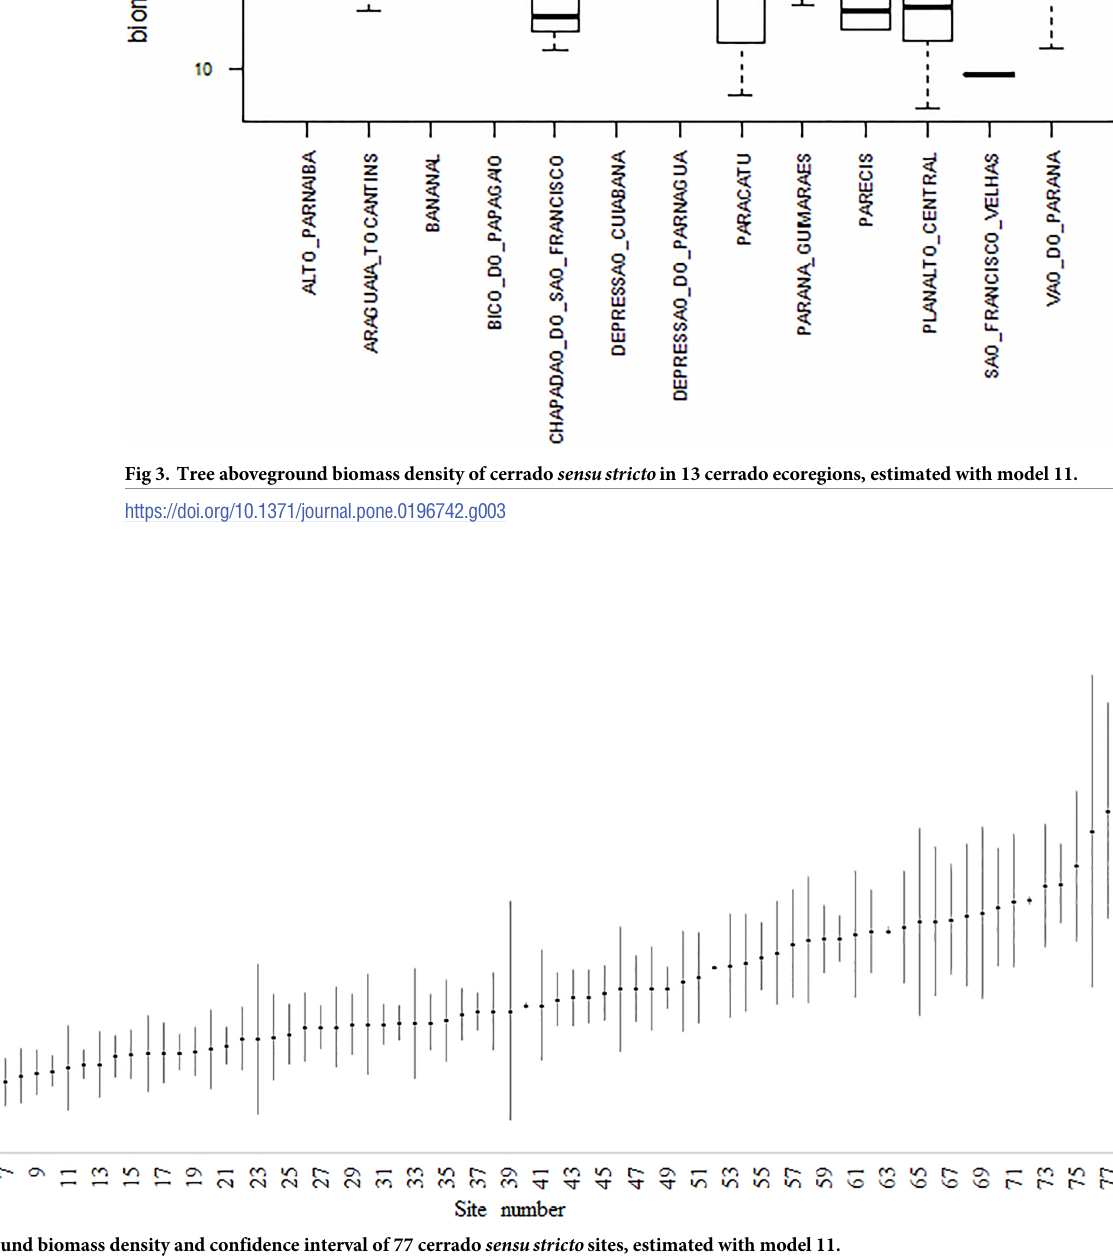
PLOS ONE | https://doi.org/10.1371/journal.pone.0196742 August 1,